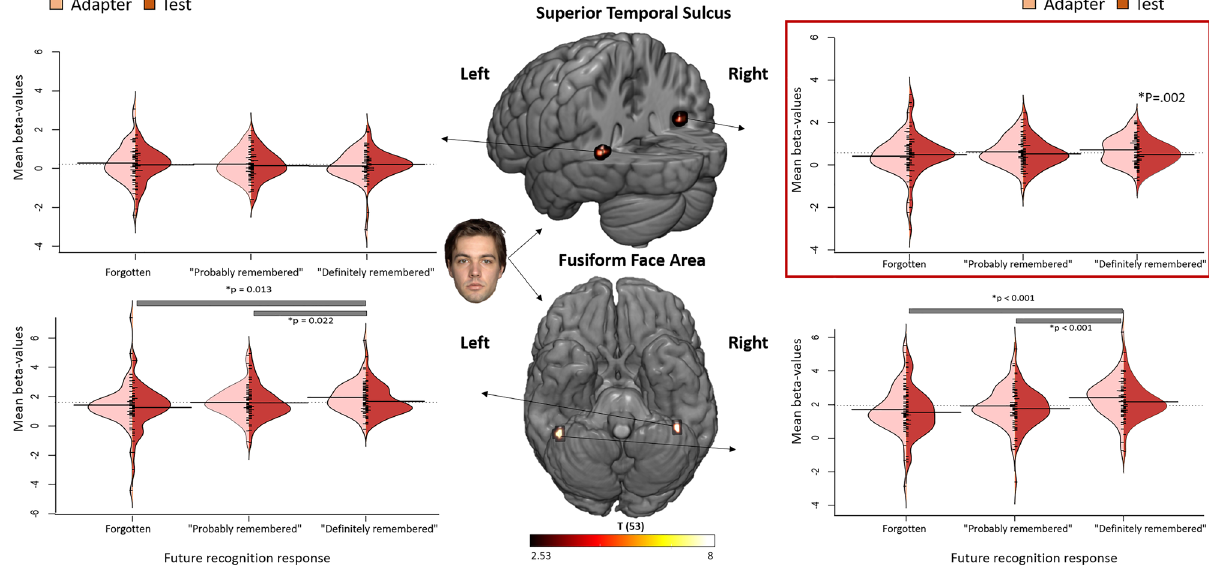
Fig. 5 Interaction between RS and differences due to memory in right pSTS. Split violin plots displaying effect size estimates (beta-values) as a function of ROI, repetition, and memory performance during delayed recognition test. Horizontal bars indicate signi fi cant differences between performance levels. Linear Mixed Model analysis reveals a signi fi cant interaction between repetition suppression and differences due to memory in the right STS ( p = 0.035, Bonferroni-corrected). The centre column displays the ROI locations and absolute t-values of the statistical maps (faces vs. houses) on which the ROI de fi nition is based ( q < 0.005, FDR-corrected). Horizontal lines represent the mean. N =